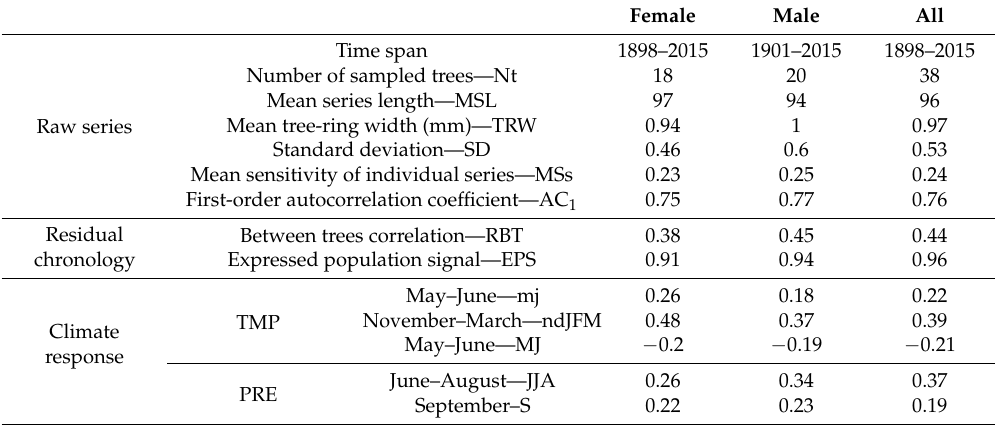
Table 2. Climate response and basic statistics of yew tree-ring series and residual chronology (common time span 1935–2015).